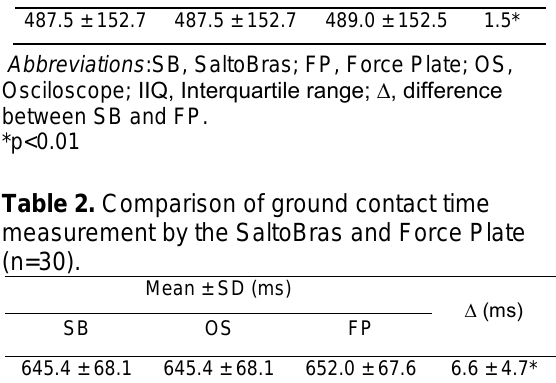
Figure 2. Linear regression of the flight time and ground contact time recorded with the force plate (FP) and the SaltoBras